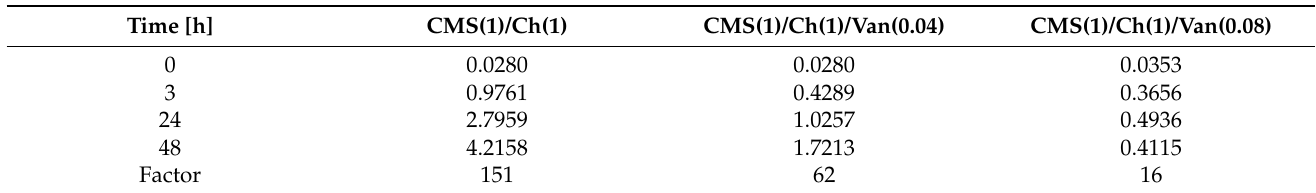
Table 9. Comparison of the results of the measurement of deep water